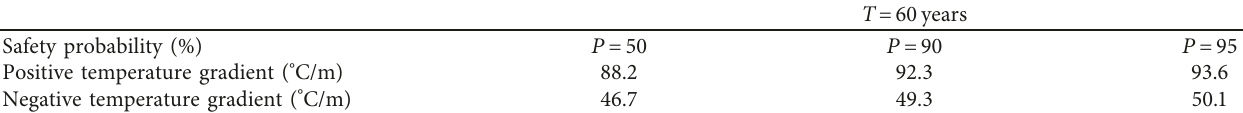
Table 4: Temperature gradient daily maximum load based on different safety probability